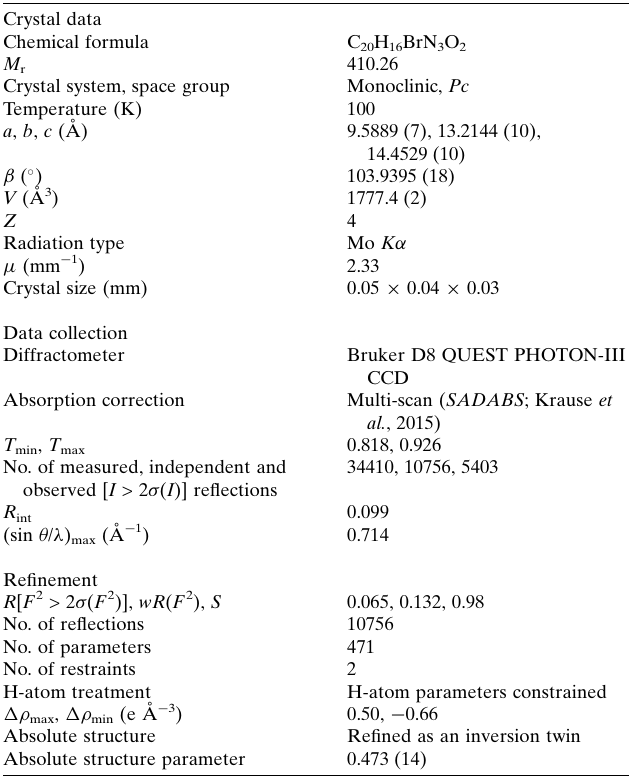
Table 4 Experimental details. Crystal data Chemical